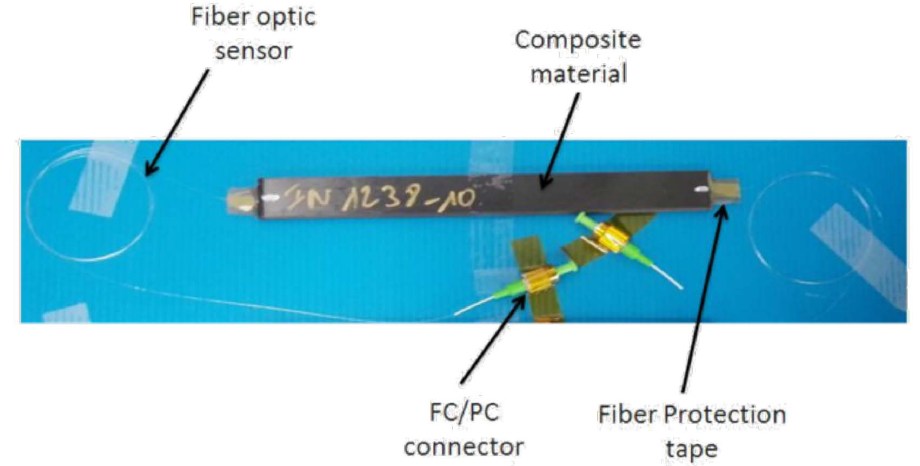
Figure 7. CFRP composite specimen with embedded FOS and